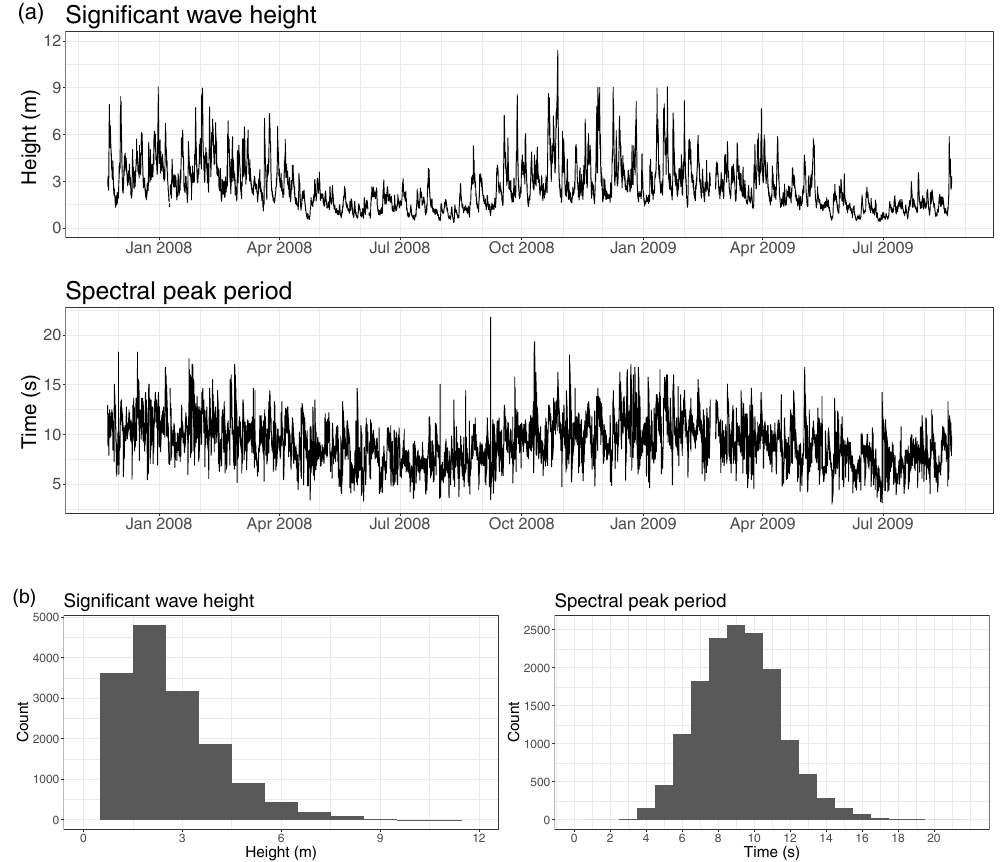
Figure 12. Measurements of significant wave height (m) and the spectral peak period (s). (a) Time series and (b) histograms.